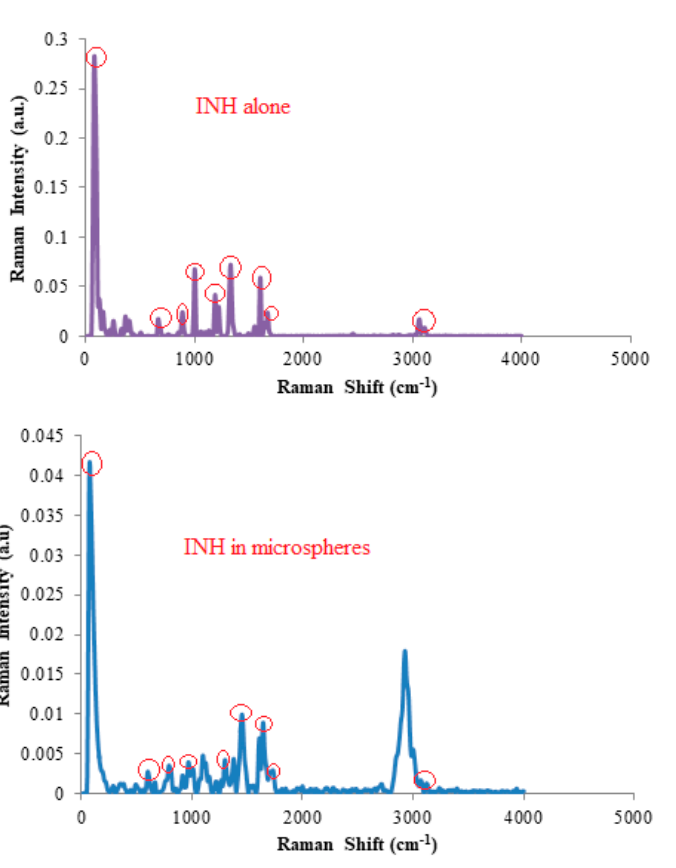
Figure 4. Typical DSC thermogram for RIF generated at a heating rate of 10 °C/min over the temperature range 30–400 °C.